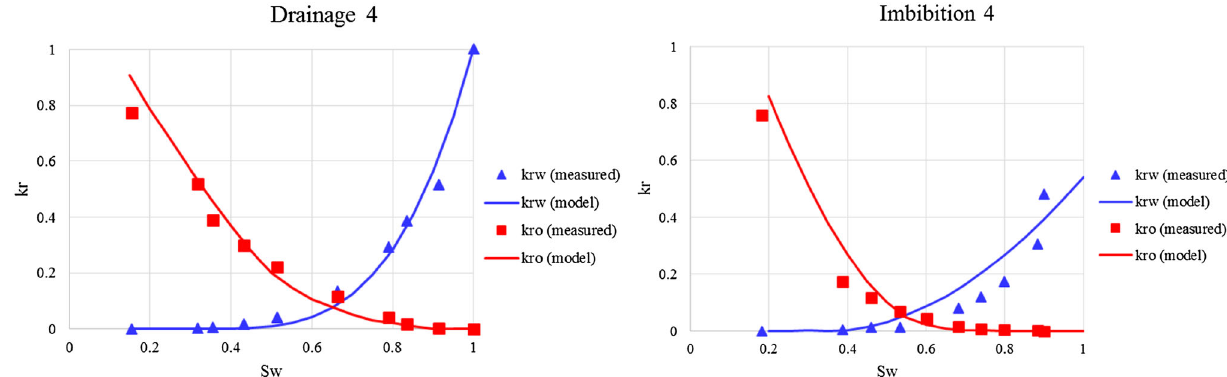
Fig. 16 Drainage and imbibition K r correlation for sample plug #4